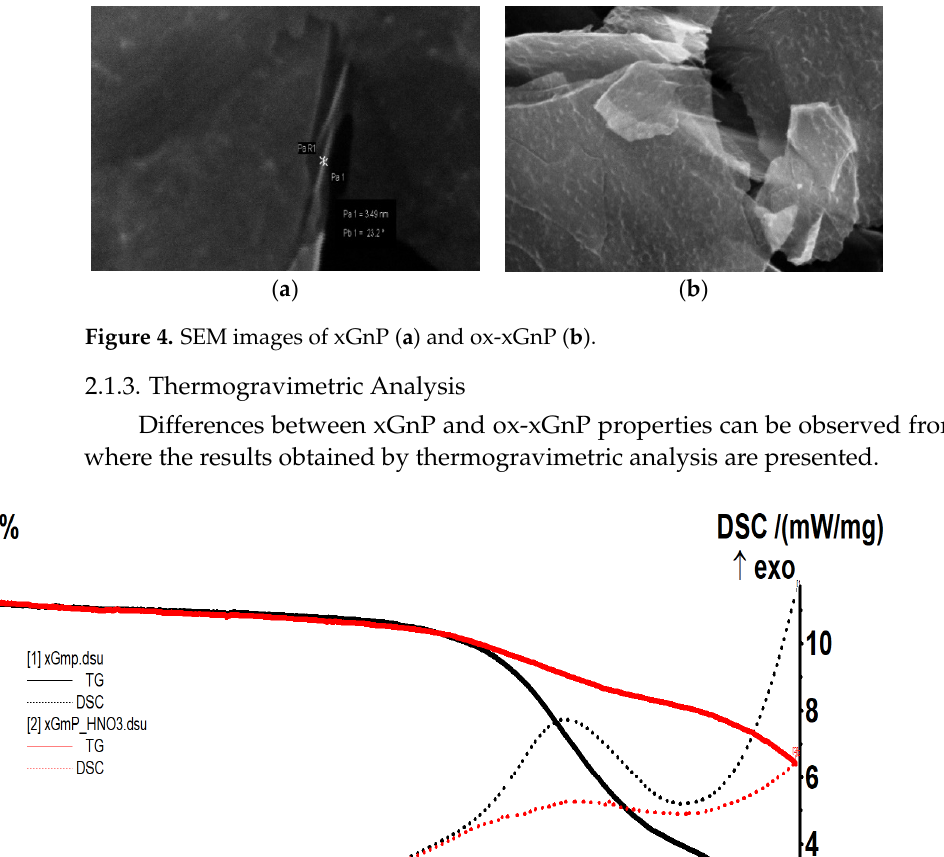
Figure 4. SEM images of xGnP ( a ) and ox-xGnP ( b ) .